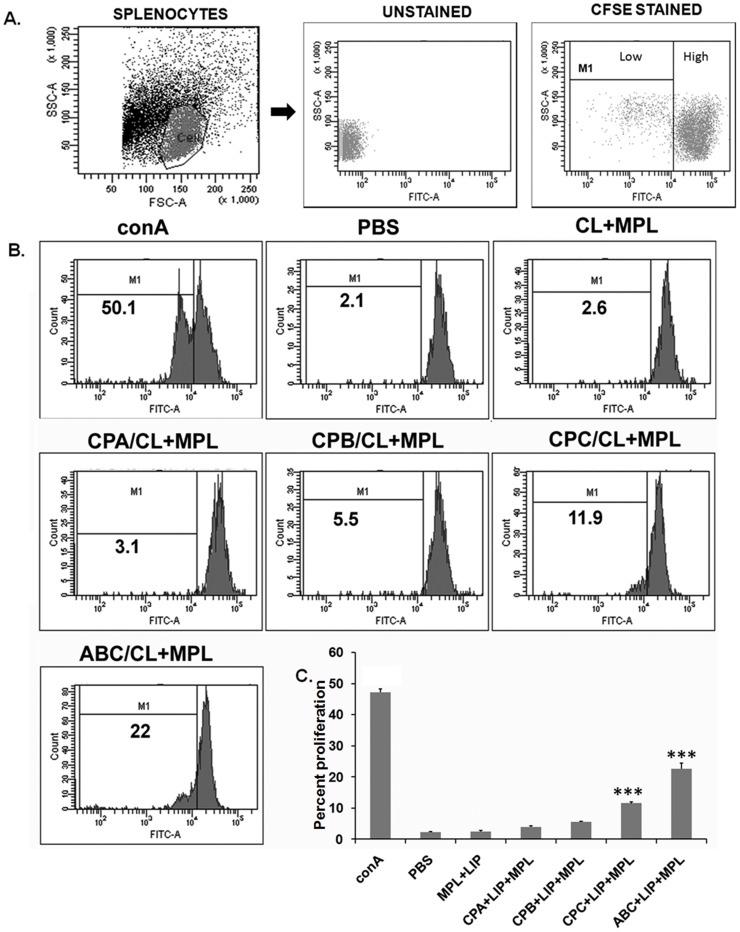
Proliferative response in hamsters vaccinated with liposomal CPs with MPL-TDM.Splenocytes from immunized animals were labeled with CFSE (2 µM) and restimulated in vitro for 5 days with 5 µg/ml of specific antigen or 2.5 µg/ml ConA. Antigen-specific splenocyte proliferation of individual animals was analyzed by flow cytometry and CFSE dilution on gated cells. A, Gating strategy for hamster lymphocytes and CFSE high and CFSE low populations. B, Representative histogram showing percent proliferation, calculated in the indicated region (bar). C, the bar graphs show mean percent proliferation of the lymophocytes, which is inversely proportional to cell divisions. The data are representative of one animal from two experiments with at least three hamsters in each group. Significant differences between means are indicated: *, p<0.05; **, p<0.01 compared to PBS controls.